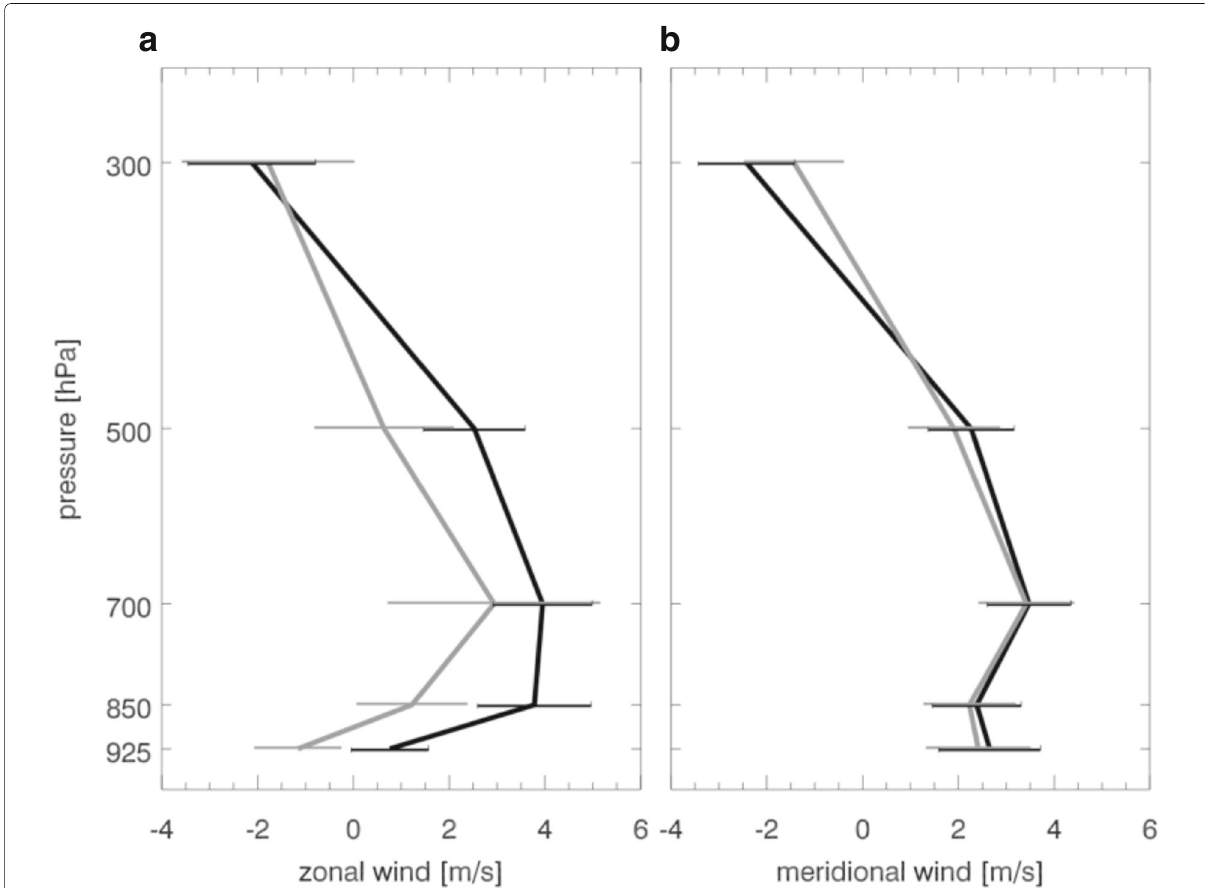
Fig. 6 Mean a zonal and b meridional wind profiles from radiosonde observations at Hanoi. The cases of HP (black; GV ratio between 0.5 and 1.2) and LP (gray; GV ratio < 0.5) are shown over the period May–Aug., for 2000–2010. Horizontal lines show mean wind 95% confidence intervals. HP and LP regional mean precipitation was calculated for the area enclosed by 22.0 − 22.7 ◦ N,103.5 − 104.3 ◦ E